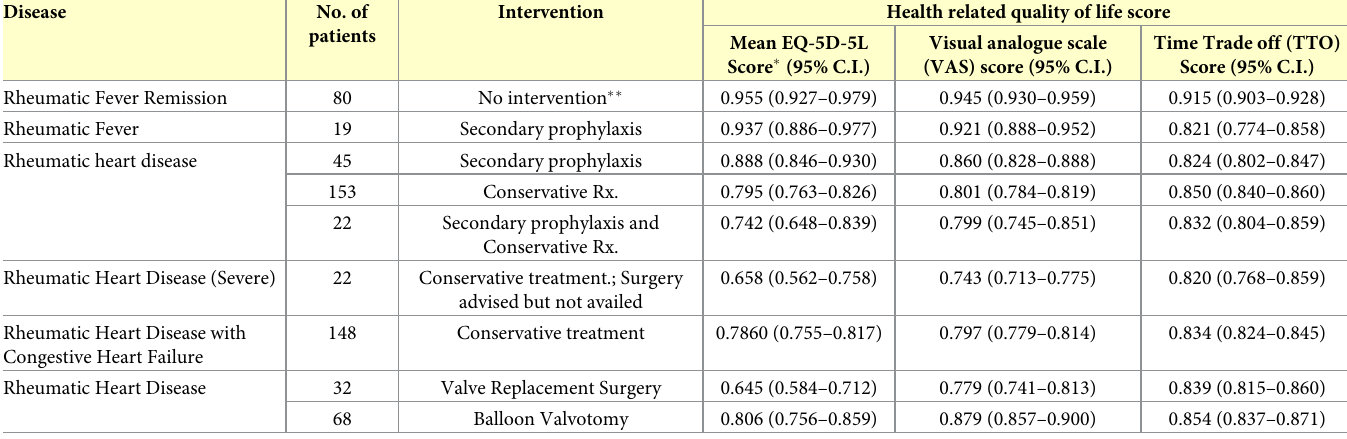
Table 4. Stage-wise quality of life scores of patients suffering from Rheumatic Fever and Rheumatic Heart Disease on the basis of different interventions.